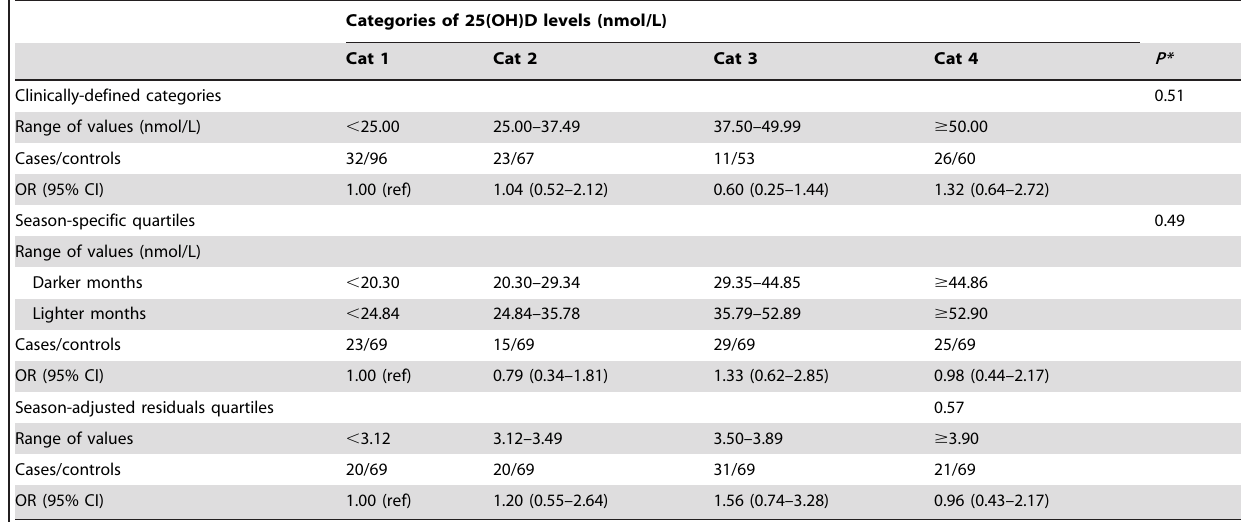
Table 2. Adjusted odds ratios of melanoma by categories of serum 25(OH)D